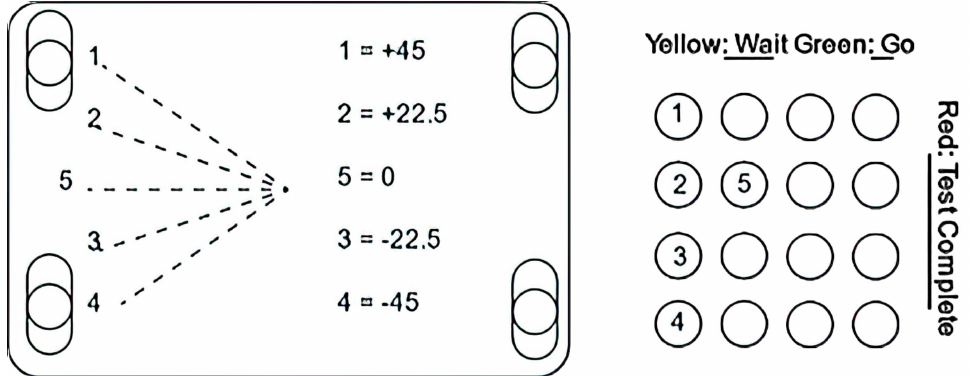
Figure 6. A reference diagram available to participants to understand the task. Localized vibration originates from the left edge of the surface, moving toward the center based on a randomly chosen angle. The keypad is represented on the right. Users select a key to be pressed based on what they feel matches with the diagram on the left. Angles on the diagram are shown from 45 to − 45